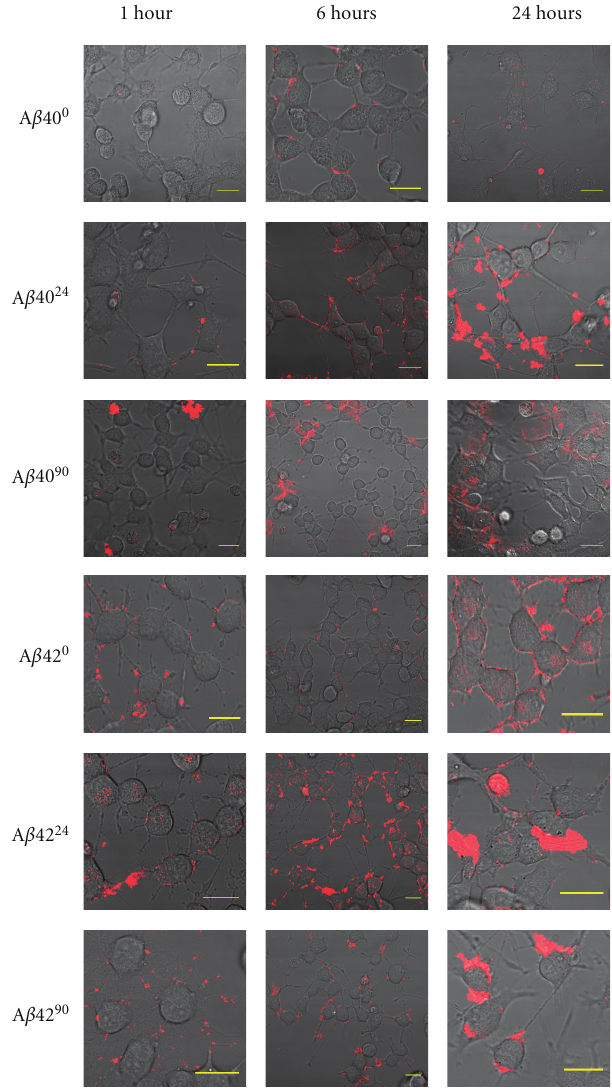
Figure 4: Confocal Microscopy images showing A β time course of cell entry. Confocal microscopy images of di ff erentiated PC12 cells treated with various A β samples exposed to endosomal conditions after 1, 6, and 24 hours. All scale bars are 20 μ m in length. A β 40 24 associates rapidly to di ff erentiated PC12 compared to A β 40 0 , whereas A β 40 90 displays weak cell association over its treatment course. A β 42 24 displays rapid internalization compared to A β 42 0 . A β 42 90 displays reduced cell interaction compared to A β 42 0 and A β 42 24